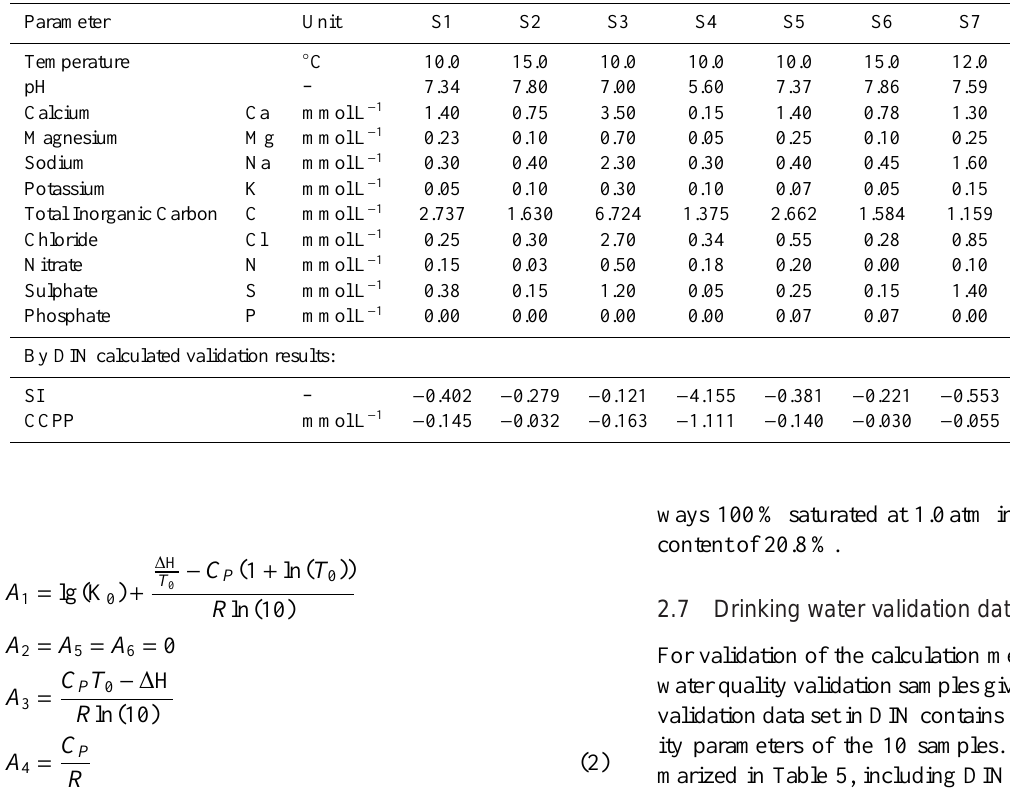
Table 5. Water quality validation data set from DIN consisting of 10 di ff erent drinking water